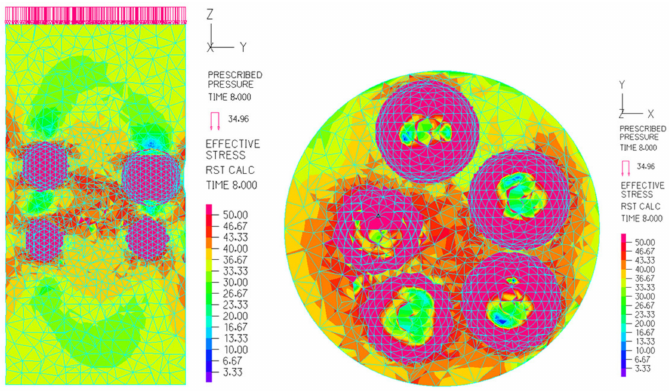
Figure 6. The internal stress diagram of SS concrete (SS50–40).